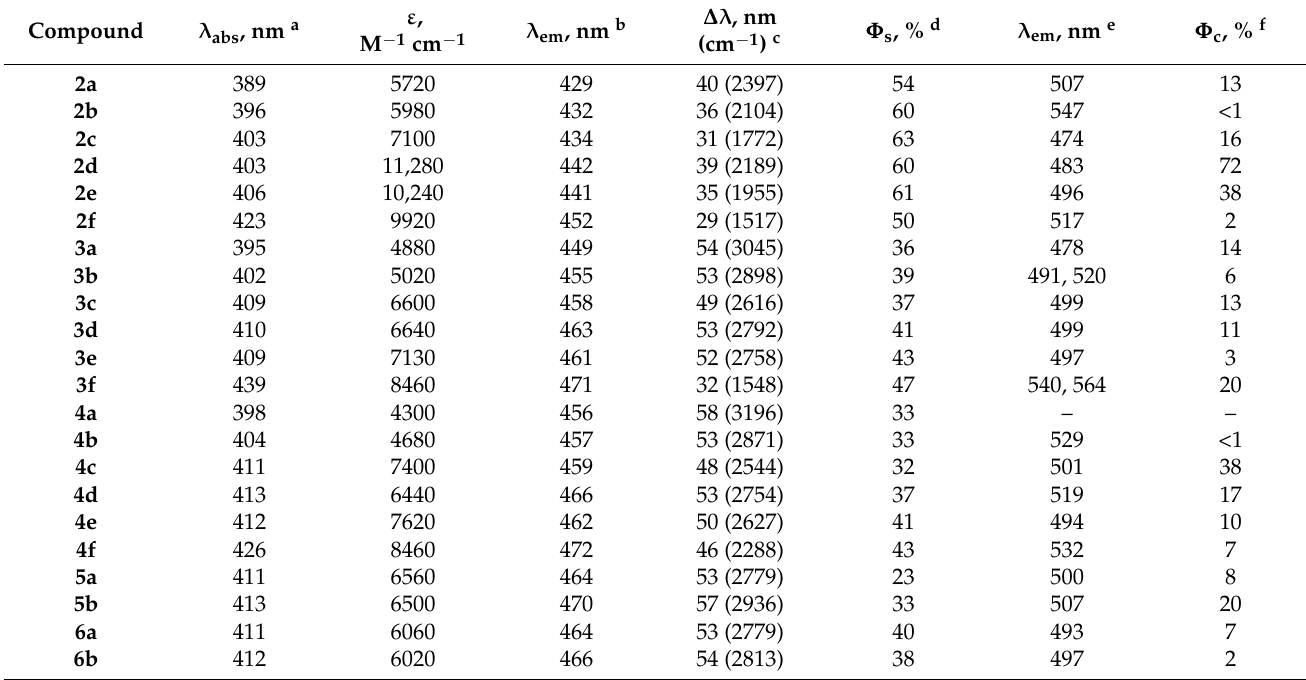
Table 3. Photophysical parameters of the synthesized 2-(butylamino)cinchomeronic dinitrile deriva- tives 2–6.